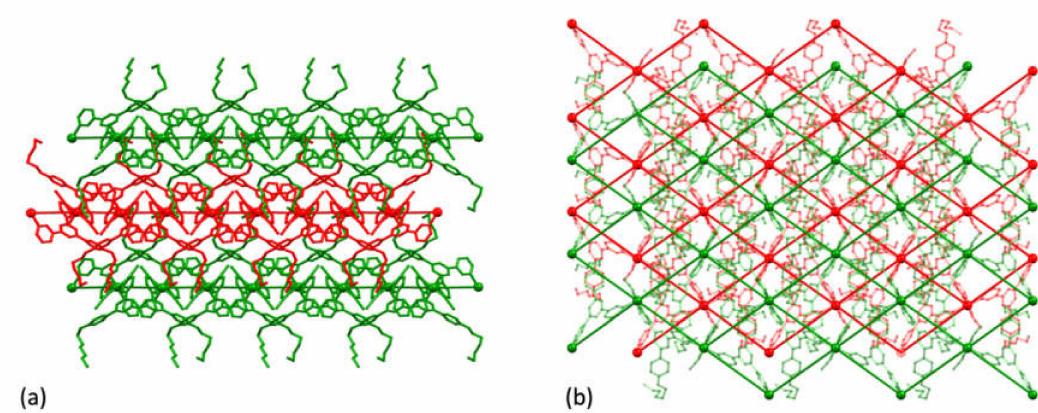
Figure 8. Staggered 2D-sheets in [Co( 6 ) 2 (NCS) 2 ] n : ( a ) view down the a- axis, and ( b ) view down the c -axis. H atoms are omitted. An analogous packing of sheets occurs in [Co 2 ( 5 ) 4 (NCS) 4 ] n . A significant point is that in the case of the reaction of Co(NCS) 2 with ligand 1 , there is competition between the formation of a (4,4) net ([{Co( 1 ) 2 (NCS) 2 } . 2.2CHCl 3 ] n or [{Co( 1 ) 2 (NCS) 2 } . 3MeOH] n [19]) and a 1D-coordination polymer [Co( 1 )(NCS) 2 (MeOH) 2 ] n , with the 1D-coordination polymer being the dominant product [19]. Powder XRD confirmed that this is not the case for the coordination polymers formed with ligands 5 and 6 , and the single-crystal structures of [Co 2 ( 5 ) 4 (NCS) 4 ] n and [Co( 6 ) 2 (NCS) 2 ]